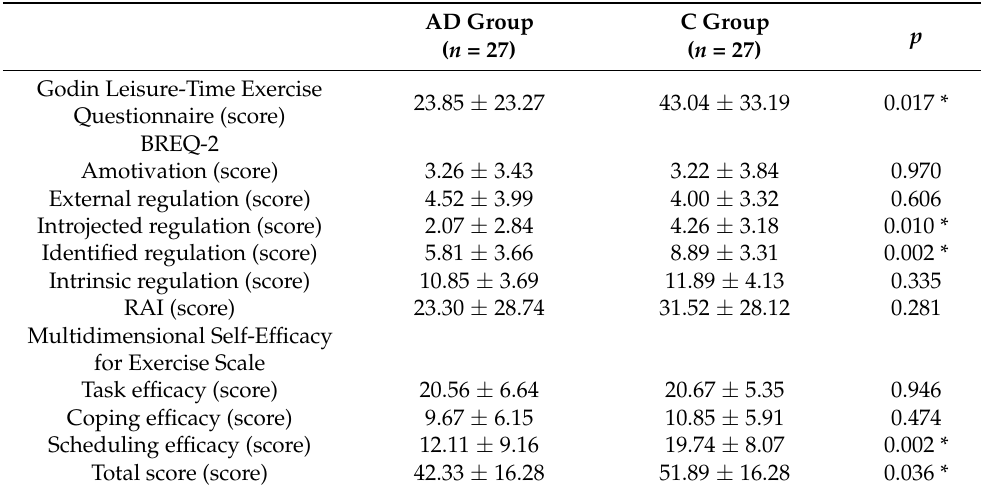
Table 3. Results of Godin Leisure-Time Exercise Questionnaire, BREQ-2, and Multidimensional Self-Efficacy for Exercise Scale in each